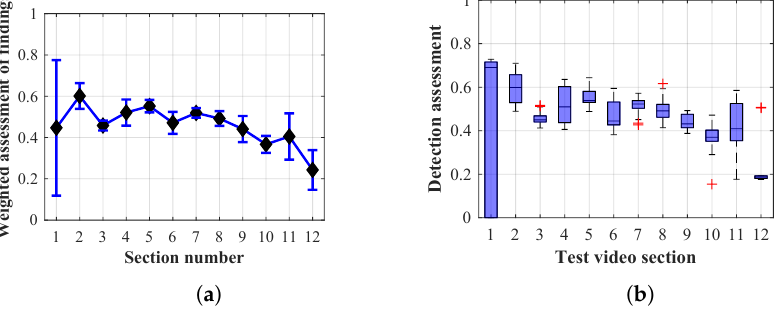
Figure 32. ResultsofMethod1.2withalifespanof40frames. ( a )theweightedaverageratingwiththeaverage mean absolute error of the weighted rating and ( b ) boxplots of the distribution of the statistical sets of the results of the individual sections evaluated indicating: minimum, 1st quartile, median, 3rd quartile,